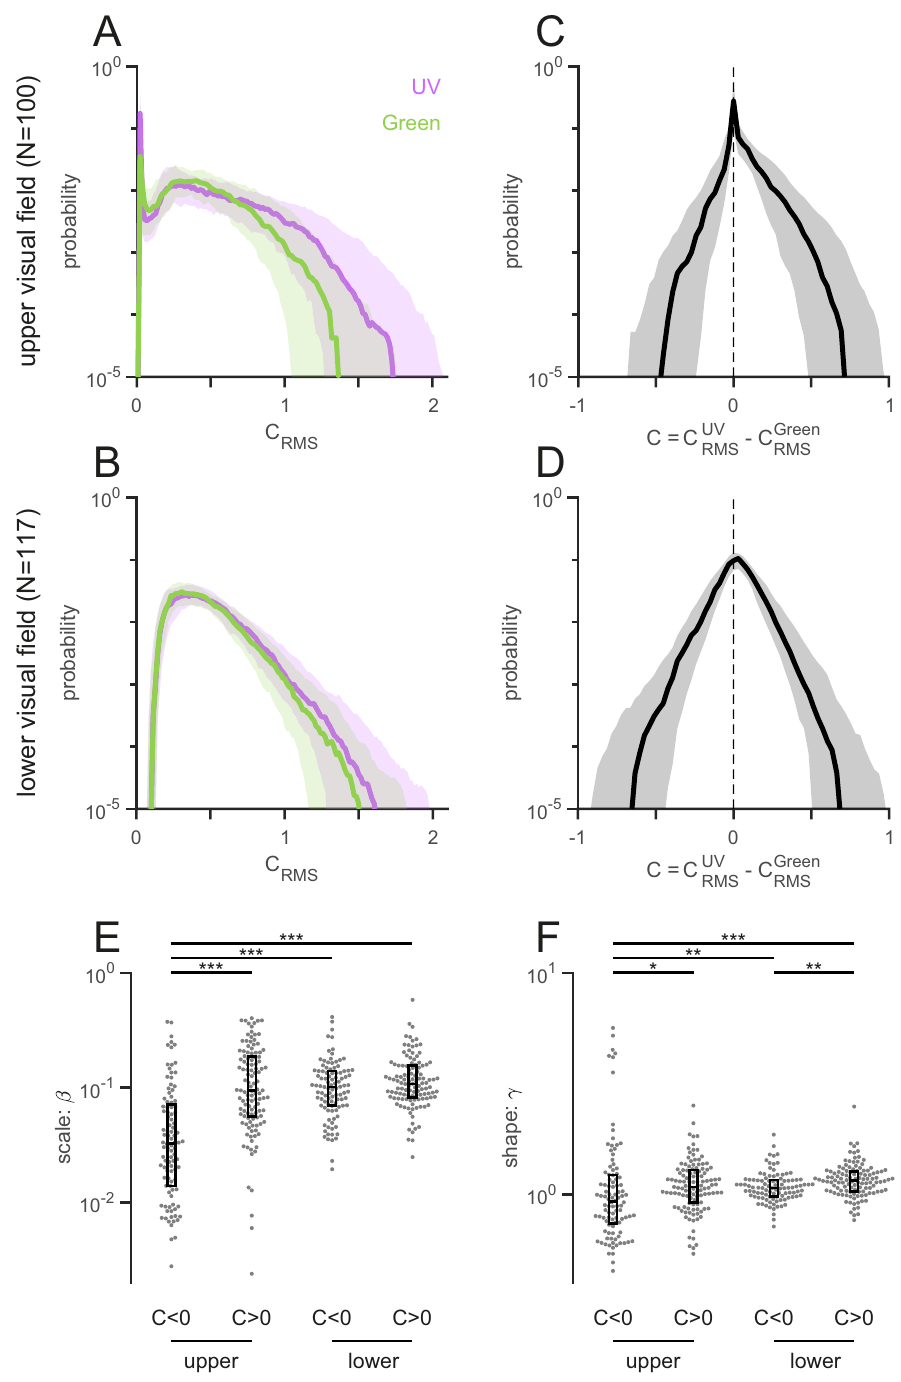
Fig 4. Achromatic and chromatic contrast of “mouse-view” images. (A,B) Root mean square (RMS) contrast of the upper (A) and lower (B) field images, computed independently for the UV (violet) and Green (green) channels of each image (local patch size, 30 pixel radius; Eq (4) in Methods). The UV channel has higher achromatic contrast, especially for the upper visual field images (median ± interquartile range). (C,D) Chromatic contrast distributions (median ± interquartile range) computed as a difference of the RMS contrasts between the UV and Green channels (Eq (5) in Methods). The distribution was asymmetric for the upper field images (C) but rather symmetric for the lower field images (D). (E,F): Scale ( β ; E) and shape ( γ ; F) parameters from the Weibull distribution fitted to each